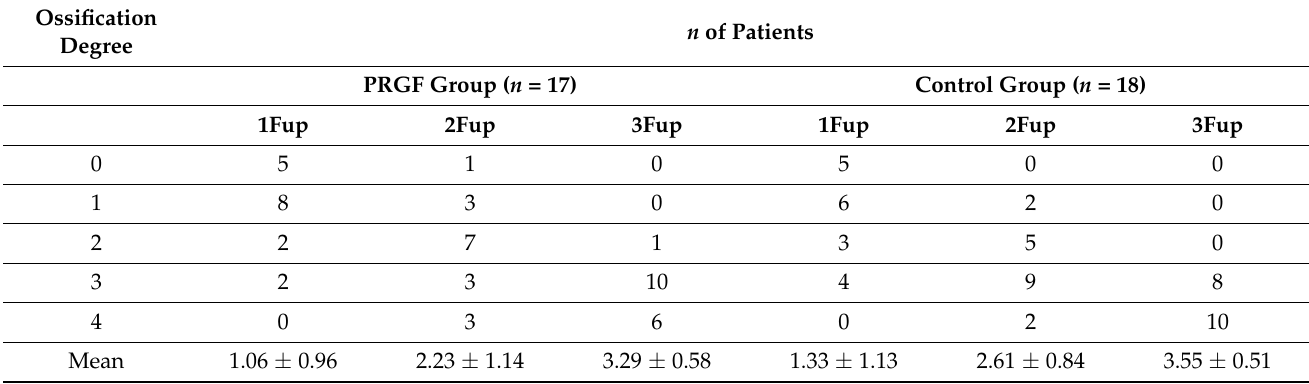
Table 3. n of patients by ossification degree.